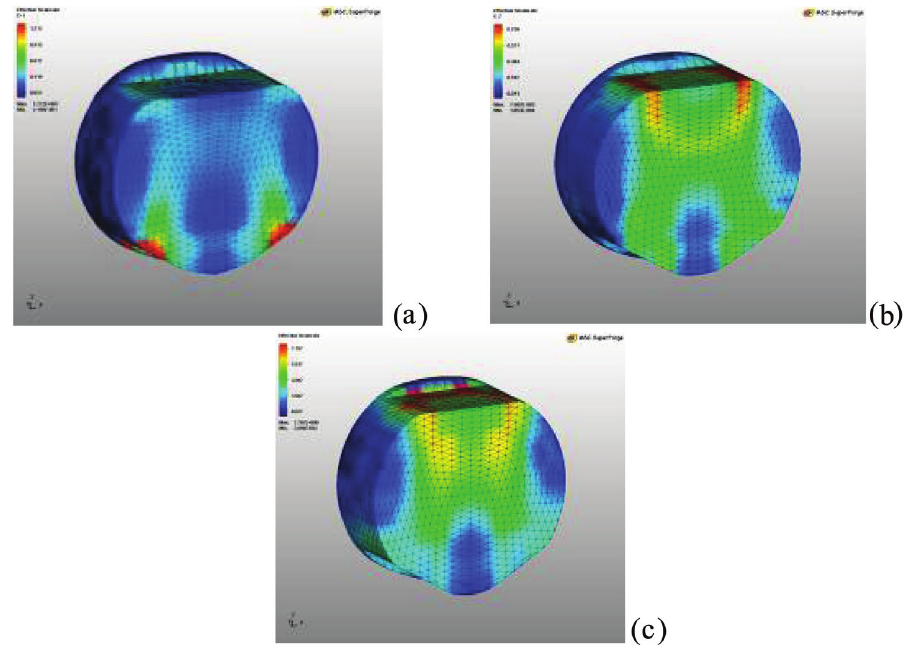
Figure 1: Picture of deformation intensity distribution when forging in the combined baizes with single reduction of 80%, t ¼ 960°C.